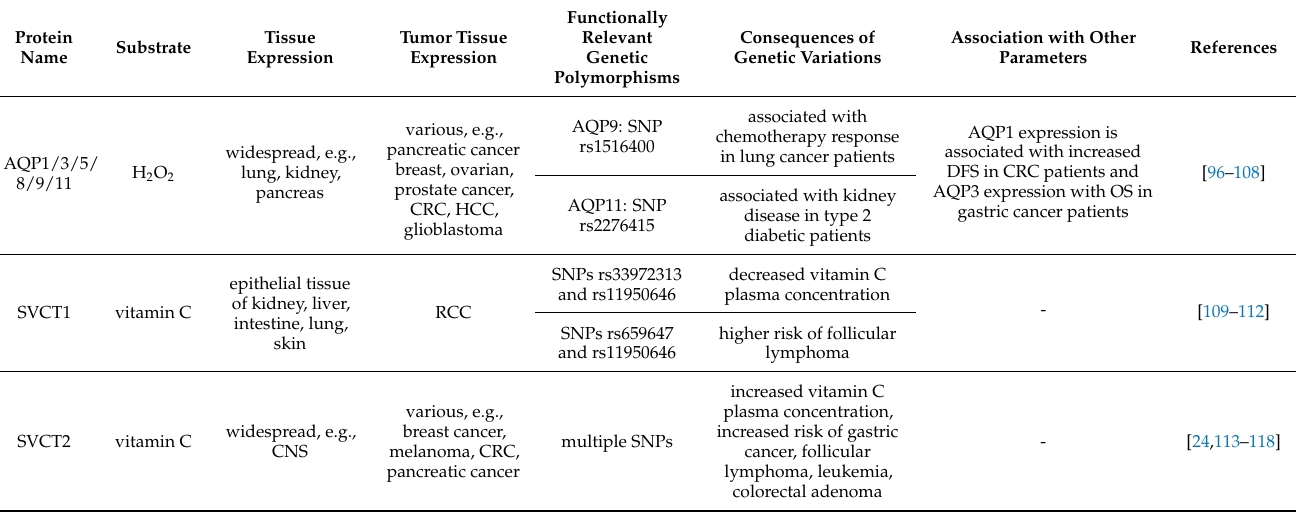
Table 1. Major proteins involved in the transport of H 2 O 2 , vitamin C, and iron across the cell membrane and their expression in normal and tumor